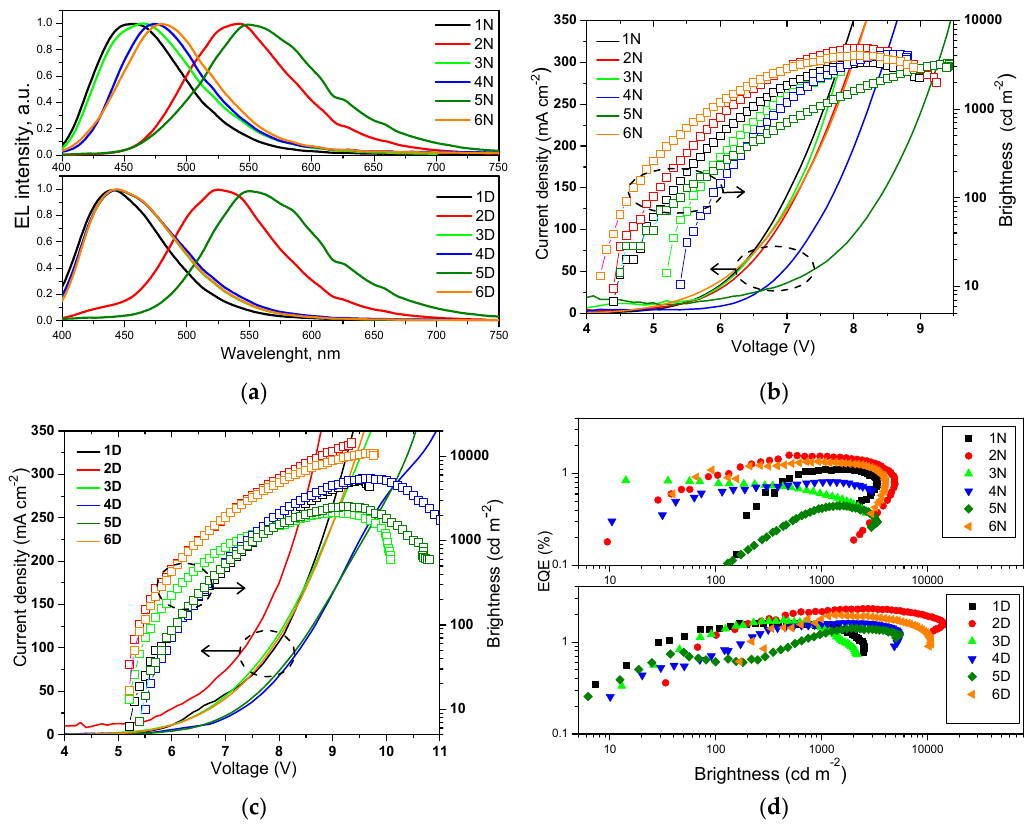
Figure 6. ( a ) Electroluminescence (EL) spectra, ( b , c ) current density ‐ voltage ‐ brightness and ( d ) external quantum efficiency ‐ brightness characteristics of non ‐ doped ( 1N–6N ) and doped ( 1D–6D ) organic light ‐ emitting diodes